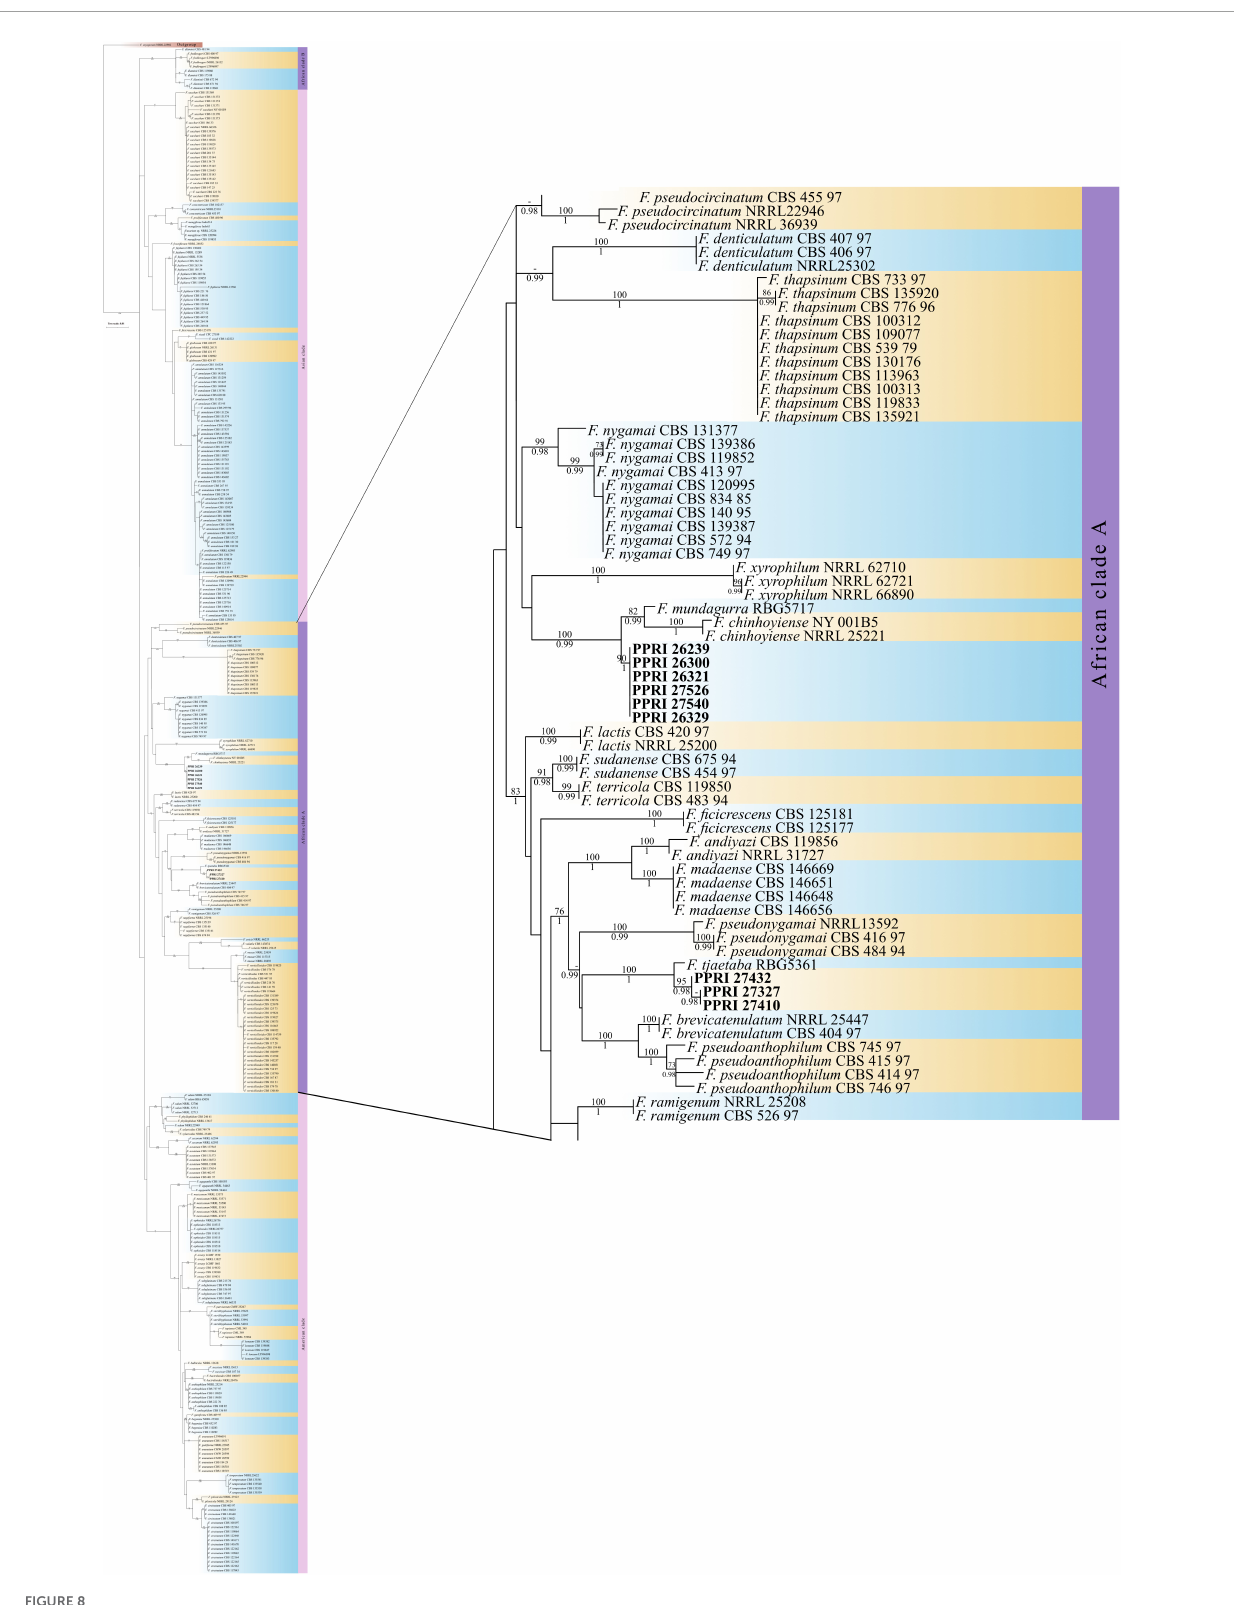
FIGURE8 Phylogenetic tree of the FFSC dataset inferred from the tef-1 α gene region for 359 taxa. Isolates from the GGHNP are indicated by PPRI number and are marked in bold. Branch support values are indicated as ML-BS/PP values ( > 0.98/ > 70%) above the branches at the corresponding nodes.